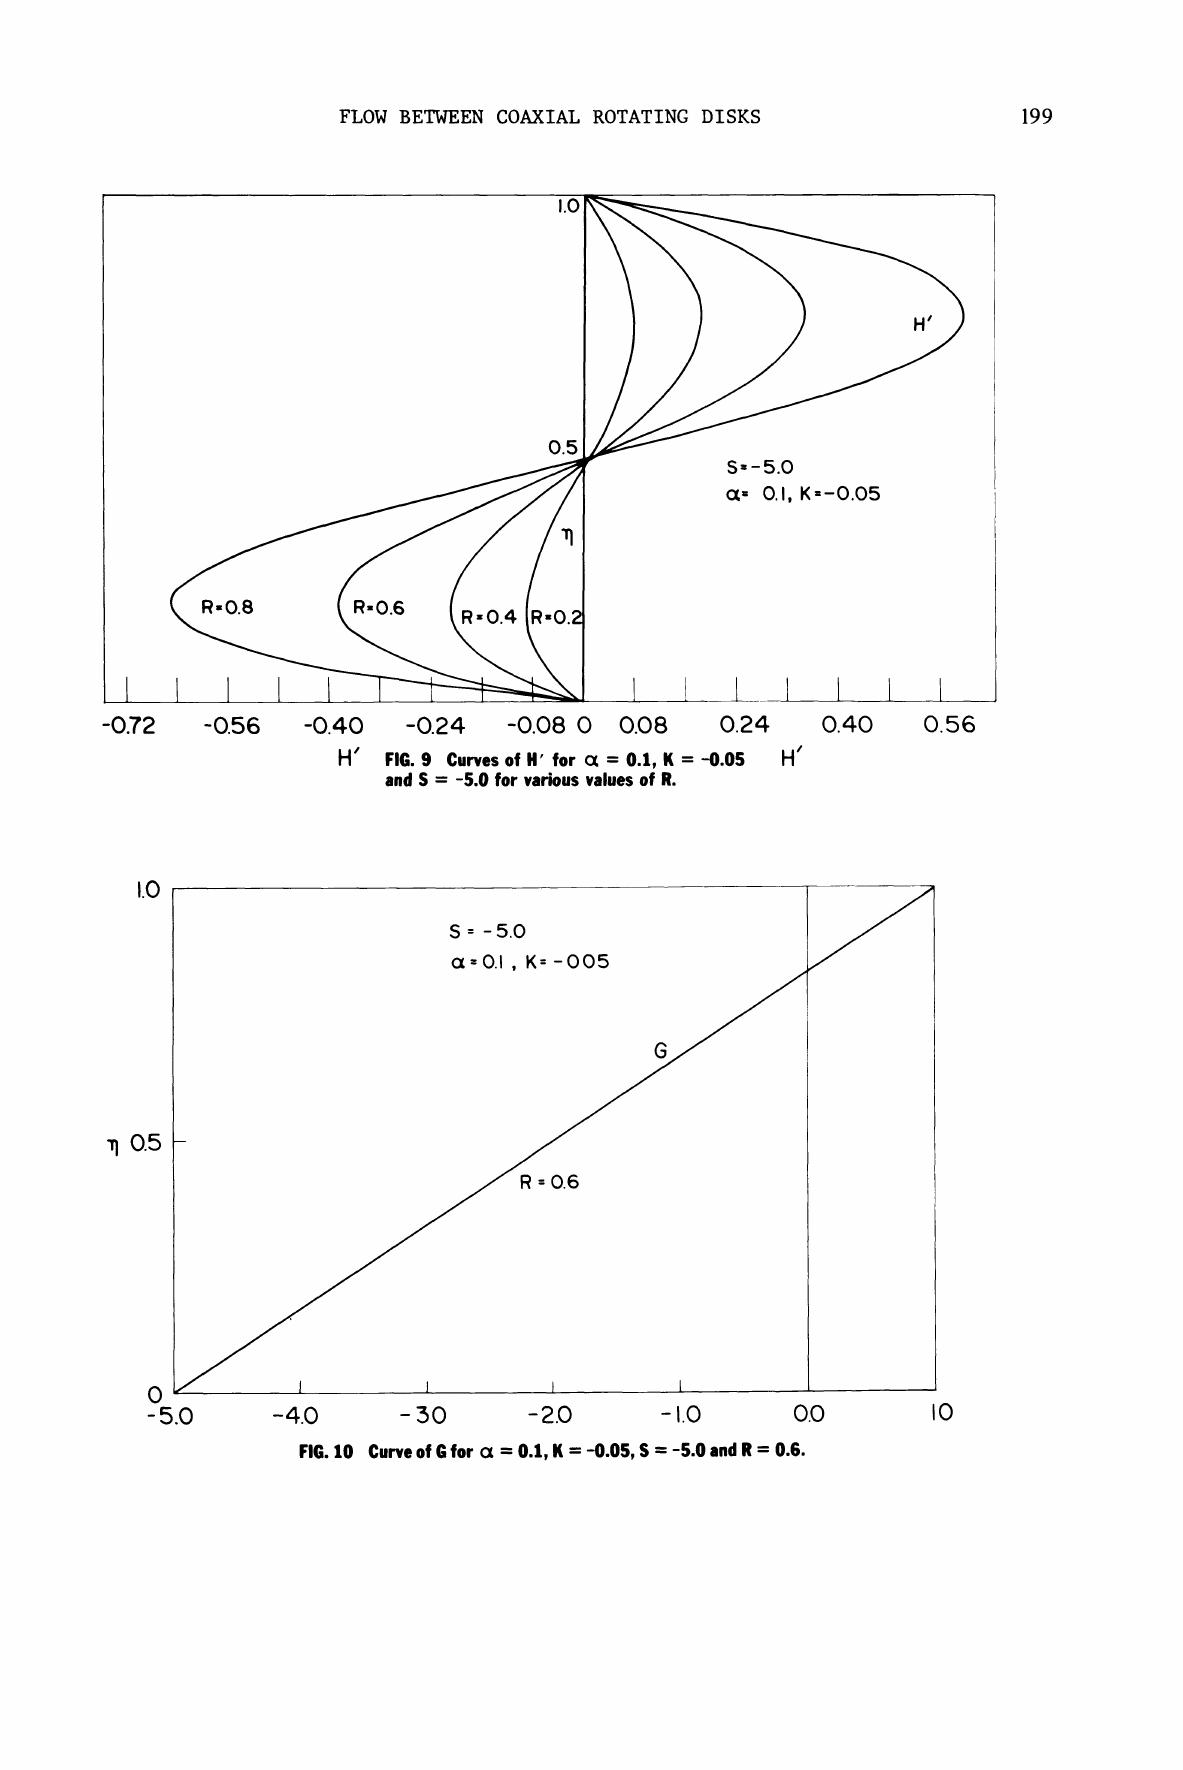
FIG. 10 Curve of G for (:x 0.1, K -0.05, S -5.0 and R